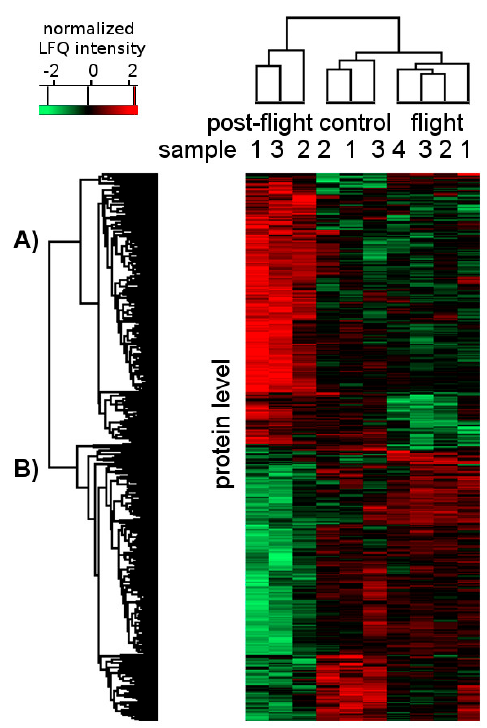
Figure 2. Hierarchical clustering of all proteins with a significantly changed expression profile between at least two groups. Significance was calculated using multiple-sample test (ANOVA model, FDR = 0.05, S0 = 0.1). Samples are clustered in columns and proteins are clustered in rows. Red marked proteins are significantly up-regulated, black marked proteins show no abundance change, and proteins presented in green are down-regulated. Clusters of proteins, which are significantly ( A ) more abundant or ( B ) less abundant in the post-flight group than in the flight or control group are shown. LFQ—Label-free quantification; FDR—false discovery rate Multiple sample testing (ANOVA test, false discovery rate (FDR) = 0.05) resulted in 442 proteins